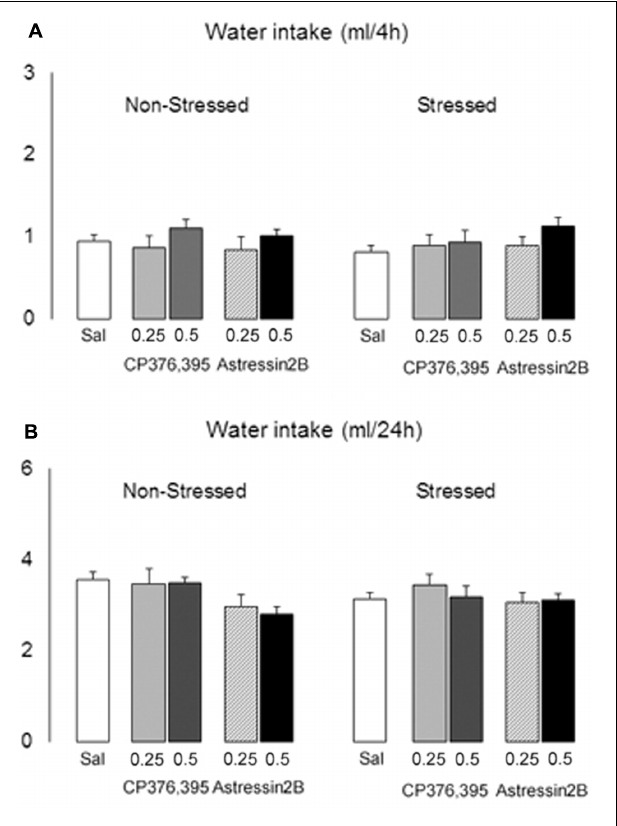
FIGURE 10 | Effects of intra-BNST CRFR1 (CP376,395, CP) or CRFR2 (Astressin2B, A2B) antagonists on water consumption in non-stressed controls and socially defeated mice exposed to continuous access to ethanol/water for 4 weeks. After infusions, mice were given continuous access to ethanol and water for 2 h, (A) 4 h and (B) 24 h. The graphs are split into non-stressed and stressed groups. Left bars represent non-stressed mice. Right bars represent socially defeated mice. Left, groups from left to right: Sal, non-stressed controls + saline, n = 20; 0.25, non-stressed controls + CP 0.25 µ g/side, n = 11; 0.5, non-stressed controls + CP 0.5 µ g/side, n = 11; 0.25, non-stressed controls + A2B 0.25 µ g/side, n = 9; 0.5, non-stressed controls + A2B 0.5 µ g/side, n = 9. Right, groups from left to right: Sal, stressed mice + saline, n = 24; 0.25, stressed mice + CP 0.25 µ g/side, n = 12; 0.5, stressed mice + CP 0.5 µ g/side, n = 11; 0.25, stressed mice + A2B 0.25 µ g/side, n = 12; 0.5, stressed mice + A2B 0.5 µ g/side, n = 12. Data are mean ± SEM.